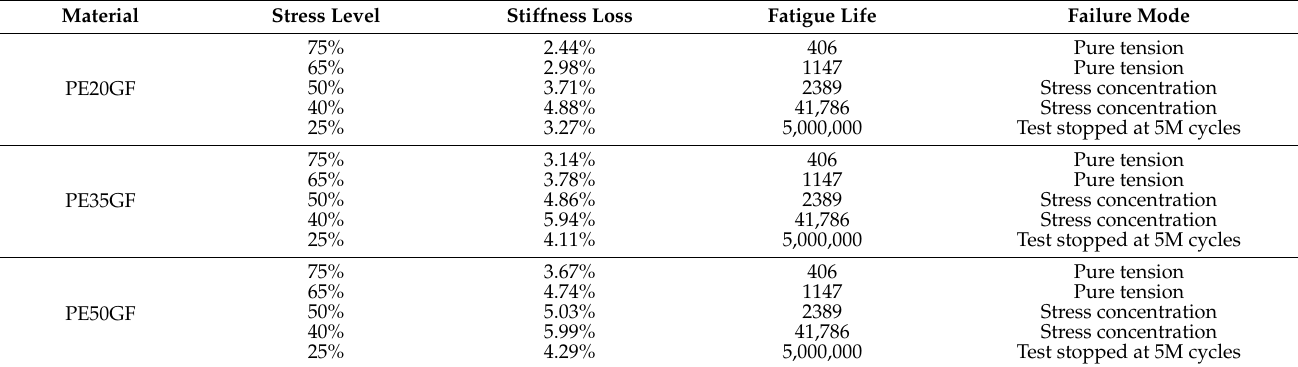
Table 4. Stress levels, stiffness loss, and failure mode of polyester composites.